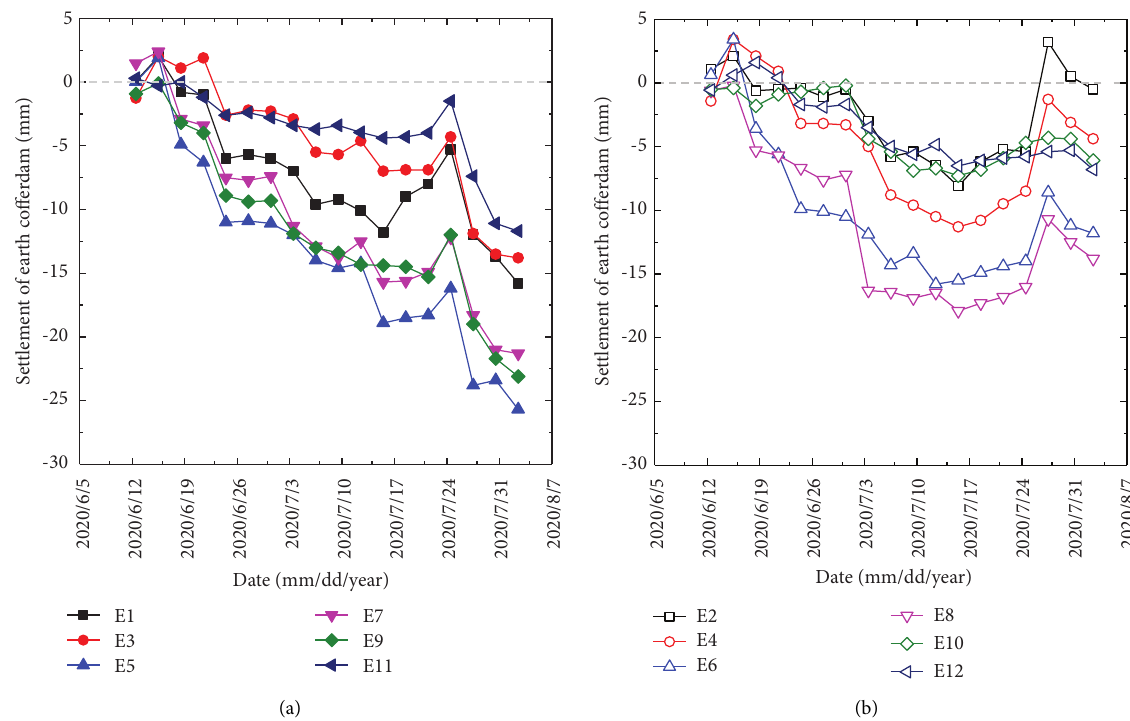
Figure 19: Variation of the measured ground settlements of the earth cofferdam with time. (a) Upstream side and (b) excavation